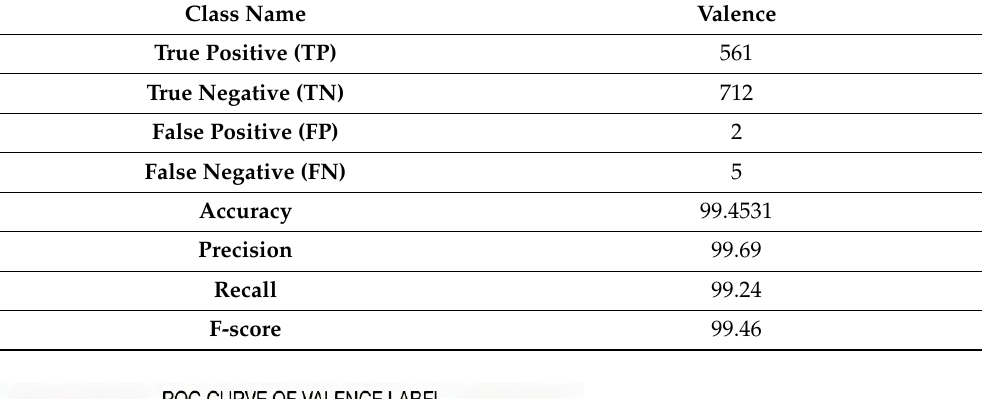
Figure 12. Confusion chart for valence label.